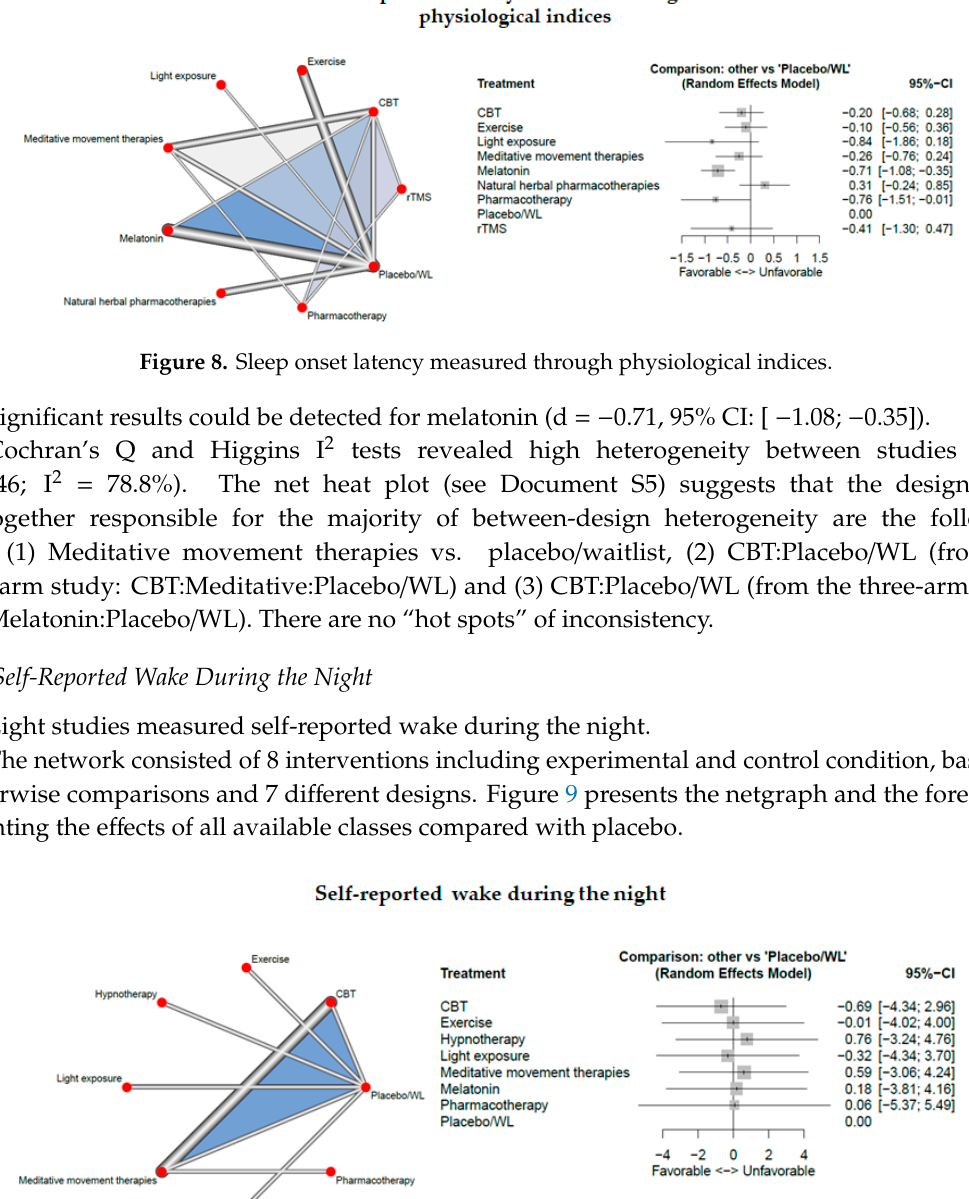
Figure 9. Self-reported wake during the night .